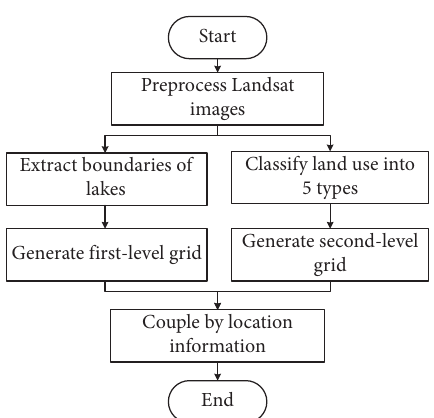
Figure 3: The rationale of ULMG.